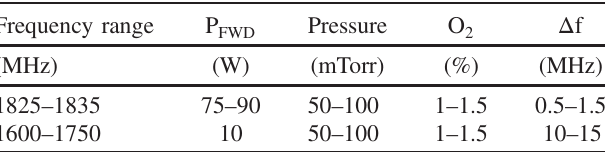
TABLE I. Summary of the parameters currently used for plasma processing. The first row pertains to the ignition of the plasma in the central cell, the second row to the parameters used to process each cell. P indicates the total power forwarded to FWD the cavity; Δ f is the frequency shift of the resonant peak caused by the ignition of the plasma and the tuning of the rf driving frequency to maximize the plasma density.